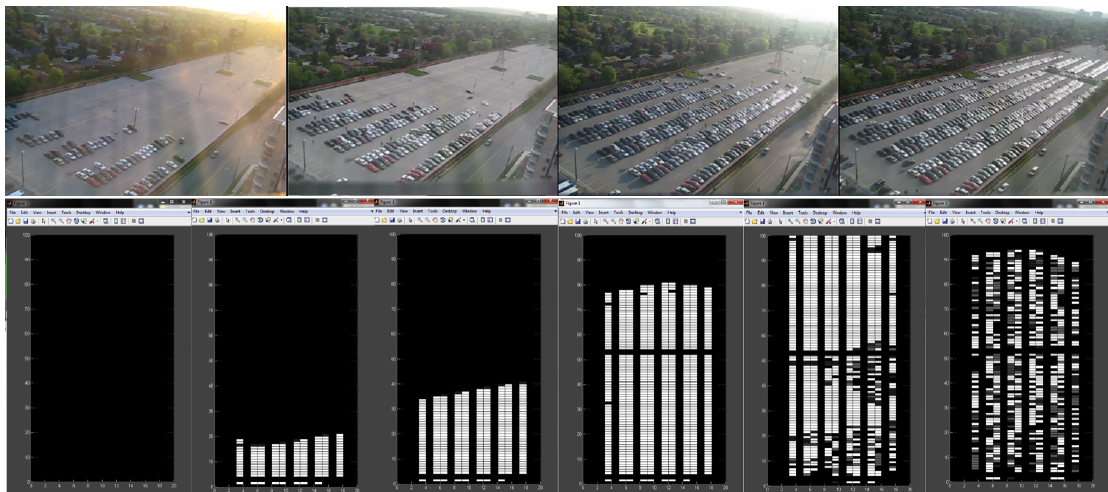
Figure 7. Simulation of cellular automata ( bottom ) to forecast the progress of parking occupancy ( top ) using Matlab.